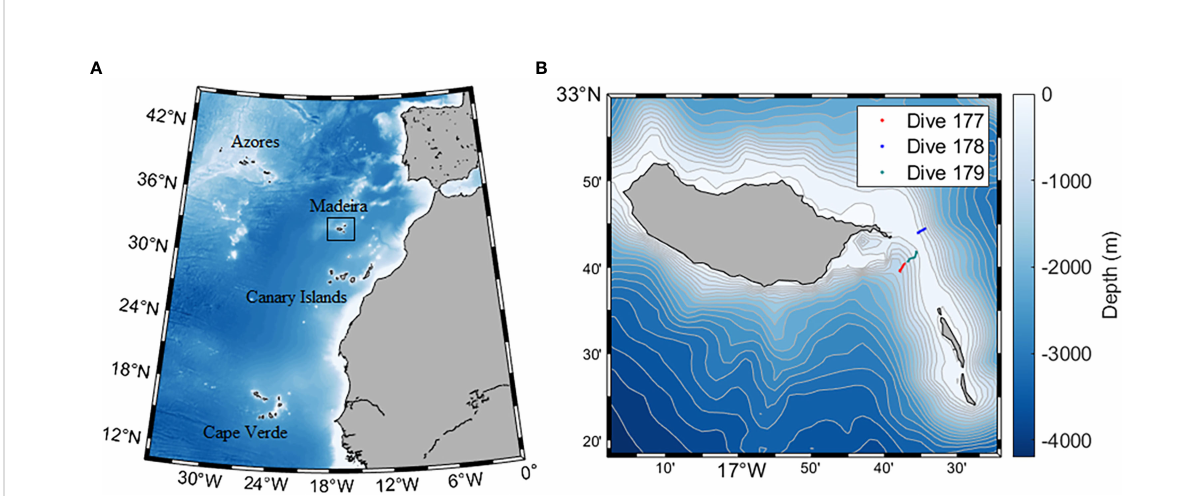
FIGURE 1 (A) Location of Madeira archipelago in the Macaronesia context. (B) Detailed map of the location of the surveyed area on the Madeira-Desertas Ridge: Western fl ank – CTD measurements and seawater collection down to 990 m depth (#177); Eastern fl ank – CTD measurements and seawater collection down to 926 m depth (#178); and upper Western fl ank towards the summit crest – CTD measurements, seawater collection and continuous sea fl oor observations down to 366 m depth